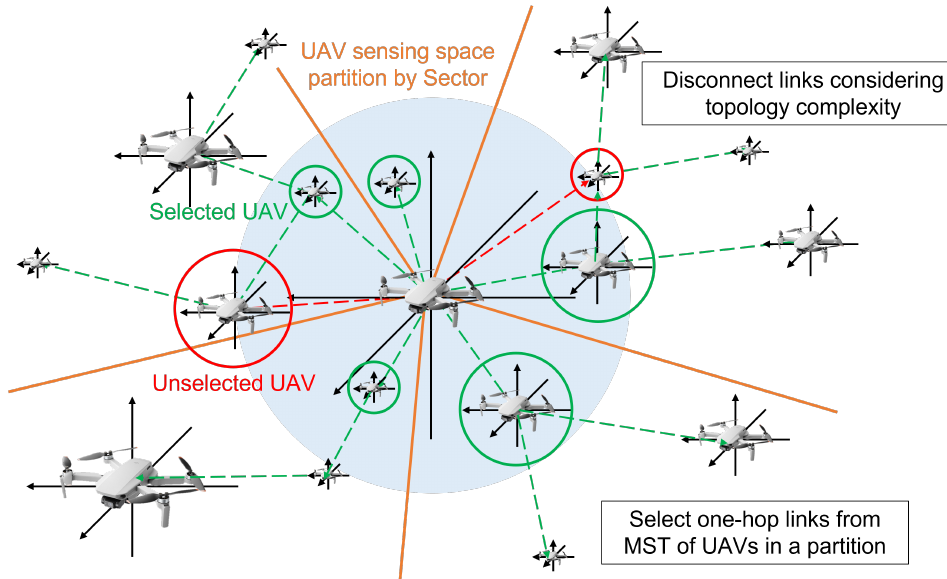
Figure 1. The overview of proposed topology control.